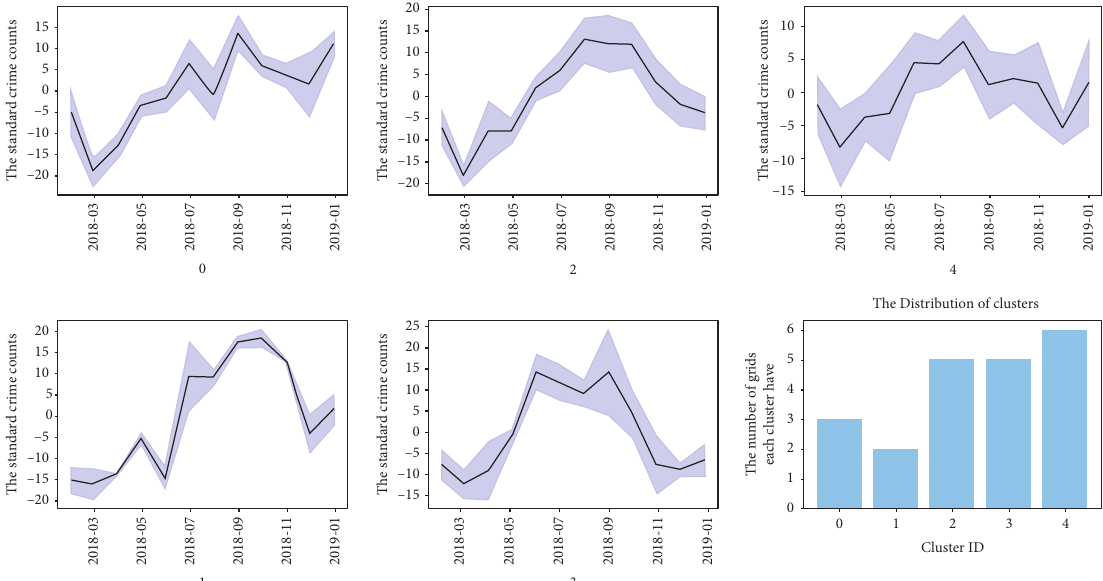
Figure 5: Chicago 2018 theft monthly trends and distribution of the clusters. The line charts are the monthly trends of theft in Chicago in 2018. The bar chart is the distribution of the clusters.